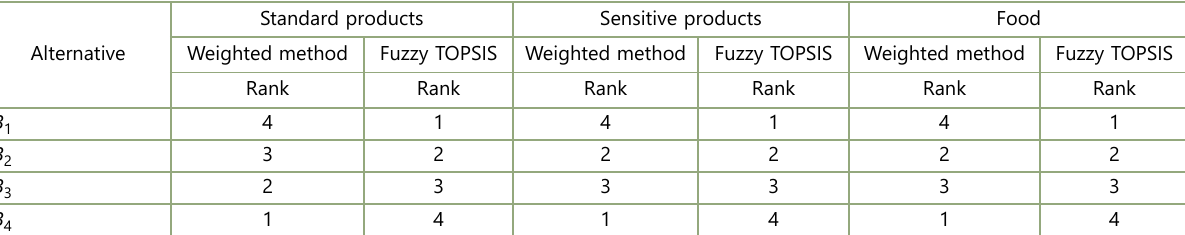
Table 22. Comparison of the obtained results for carrier selection based on classical method and the proposed fuzzy TOPSIS approach (source: own